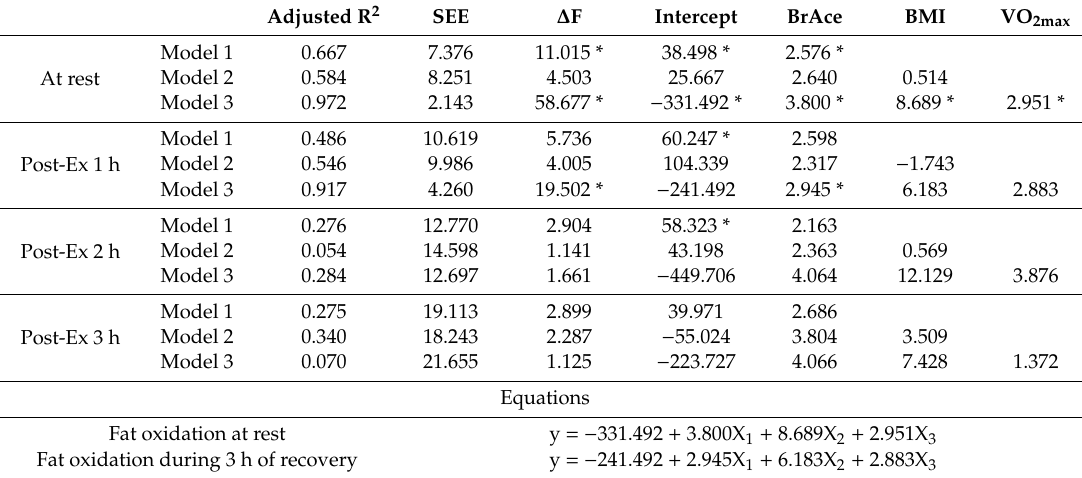
Table 3. Prediction equation model development of lipid oxidation using breath acetone.